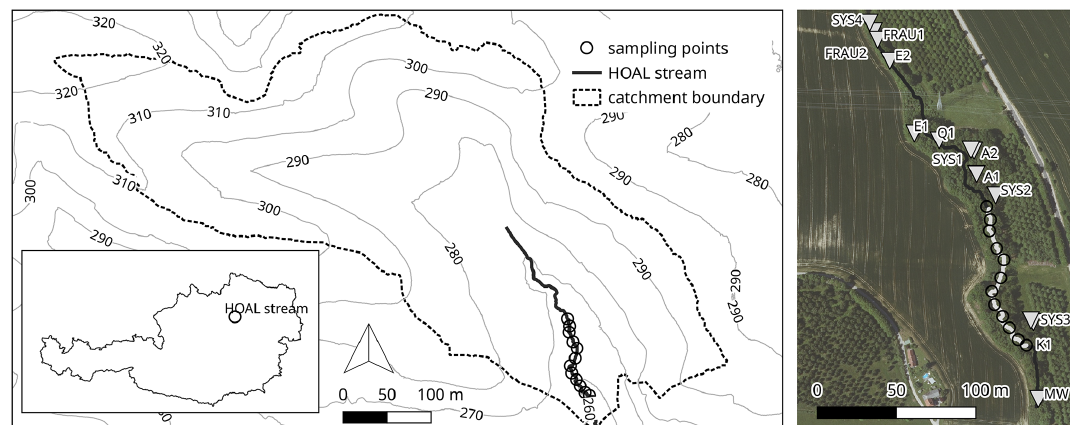
Figure 1. Hydrologic Open Air Laboratory (HOAL): catchment, stream, sampling points, and location within Austria. A satellite image of the site also shows the inflows before and after the sampling stretch (catchment outlet: MW; inlet: SYS4; tile drains: FRAU1, FRAU2, SYS1, SYS2, and SYS3; erosion gullies: E1 and E2; springs: Q1 and K1; wetland run-off: A1 and A2). GIS data and aerial provided by the Bundesamt für Wasserwirtschaft in Petzenkirchen, Austria.